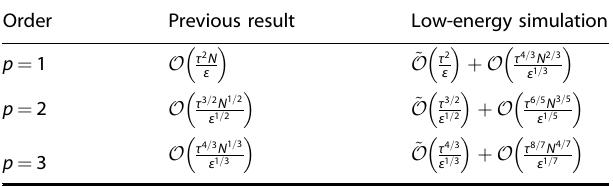
Results show the Trotter number for constant Δ and local Hamiltonians on N spins with constant degree and strength bounded by J , and τ = ∣ t ∣ J . ε is the approximation error. The ~ O notation hides polylogarithmic factors in τ / ε